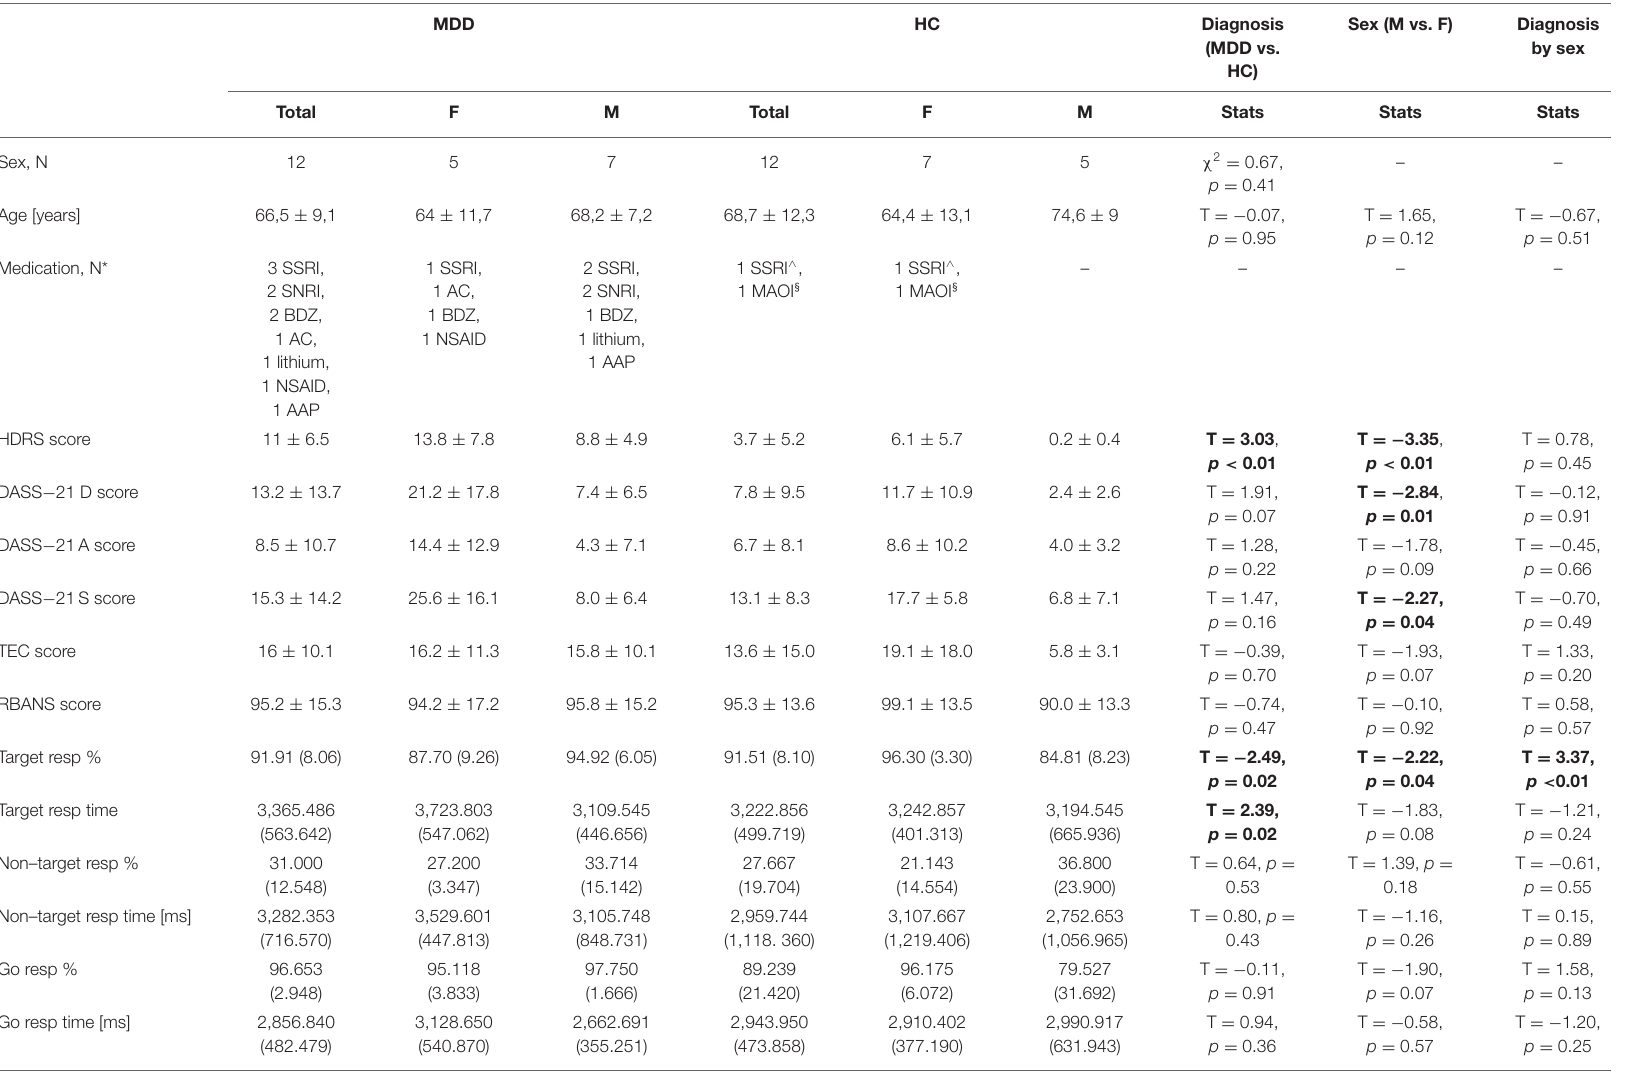
TABLE 1 | Demographic, clinical, and cognitive information of the sample.